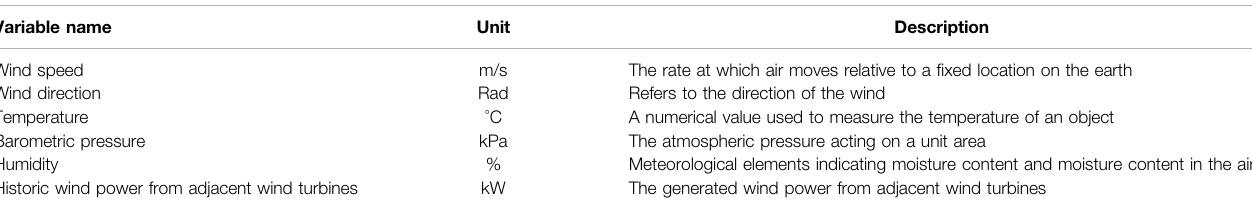
TABLE 1 | Summary of the dataset in the case